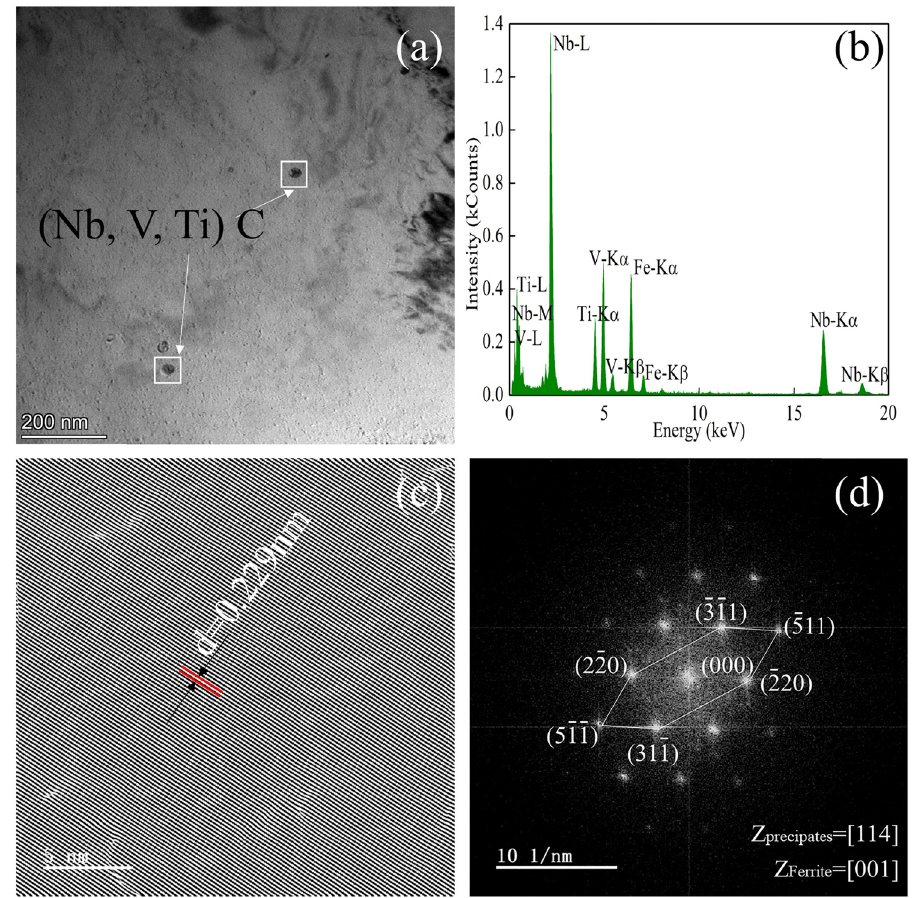
Figure 6: TEM images of ( Nb, V, and Ti ) C precipitates in the experimental rebar at 60 s. ( a ) Morphology, ( b ) energy - dispersive spectrometry ( EDS ) , ( c ) lattice fringes, and ( d )